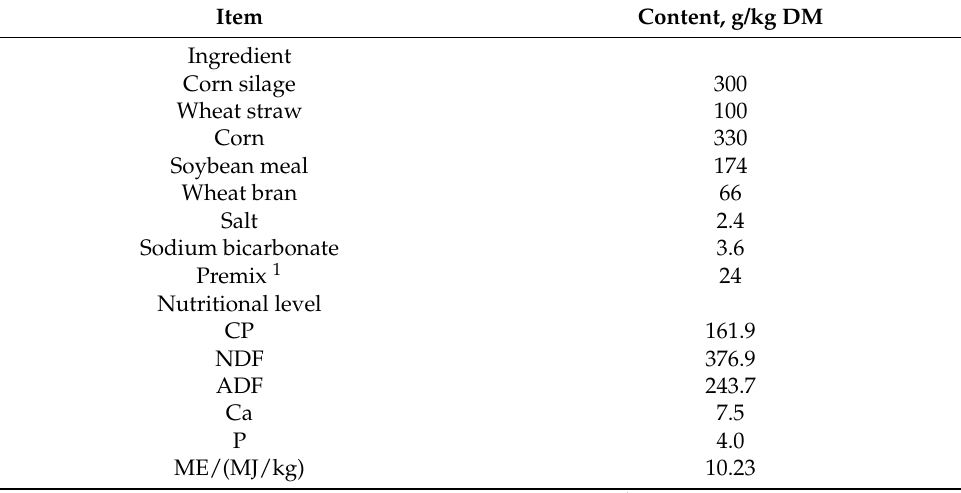
Table 1. Ingredients and nutritional compositions of the experimental